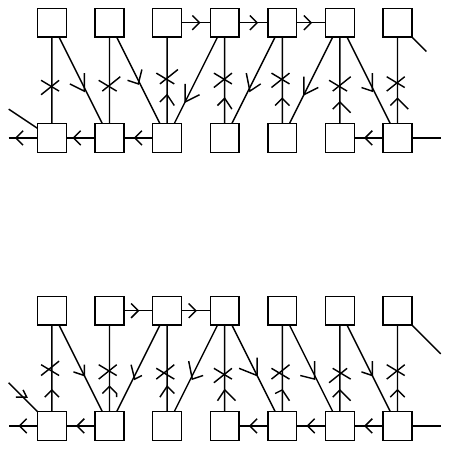
Figure 21 . This is S gluing for A theories. The two punctures have opposite sign, same orien- tation, and di(cid:11)erent color. We glue the left and right punctures with S gluing turning on W S